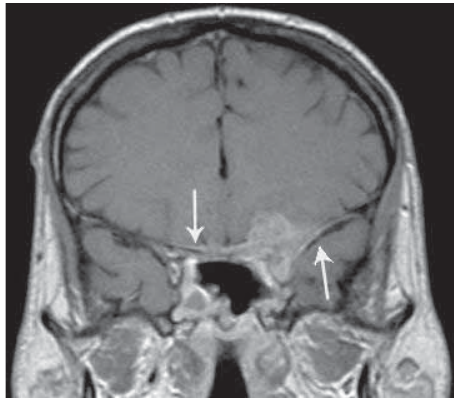
FIGURE 13. The coronal T1-weighted contrast-enhanced MR image shows an in fl ammatory mass in the left frontal lobe in the patient with Wegener's granulomatosis, focal thickening and enhancement of the dura overlying the anterior aspect of the left temporal lobe-dural tail